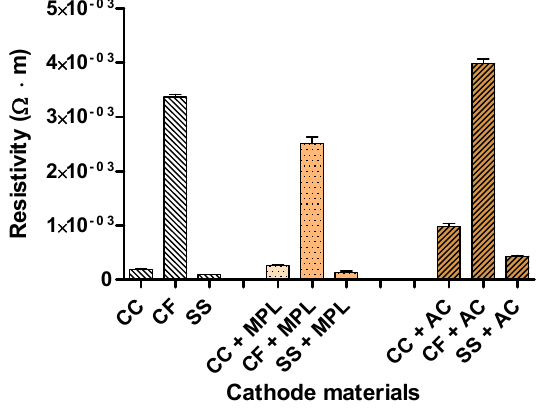
Figure 4. Electrical resistivity of the different substratum materials and cathode electrodes with a MPL layer and an AC layer.